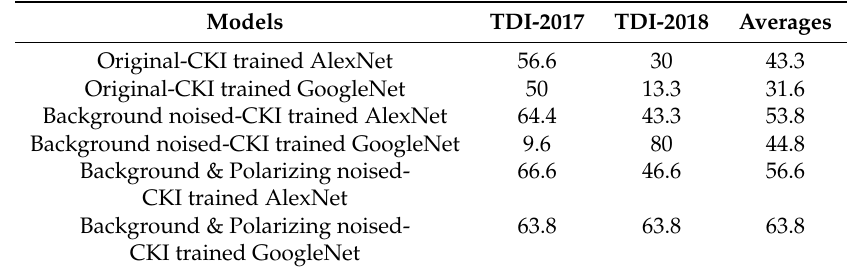
Figure 9. Classification results with TDI-2017 and TDI-2018 by AlexNet and GoogleNet trained with Original-CKI, Background noised-CKI, and Background & Polarizing noised-CKI. Table 1. Classification results through AlexNet and GoogLeNets via Original CKI, Background noised-CKI, and Background & Polarizing